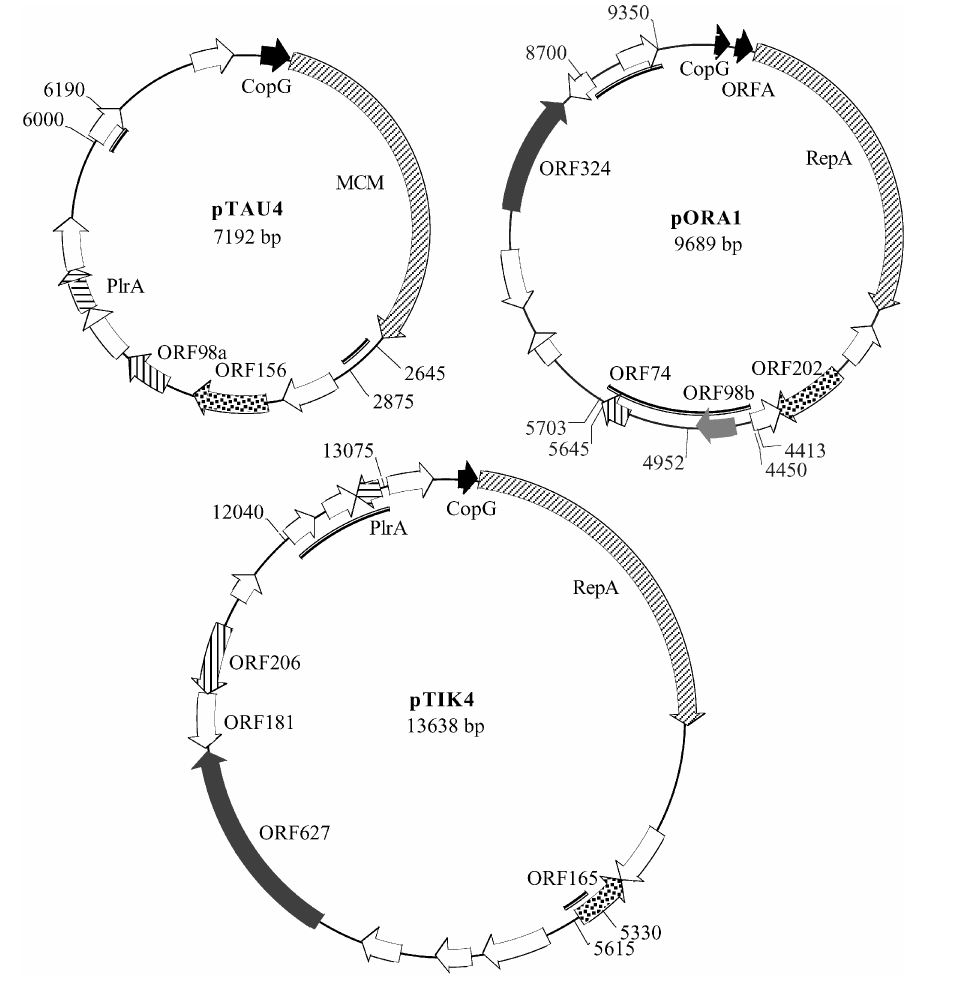
Figure 1. Circular gene maps of plasmids pTAU4, pORA1 and pTIK4. Open reading frames (ORFs) presented in ei- ther black, or identical pat- terns, are homologous. Gray- shaded ORFs yield matches in public sequence databases (see Table 1). Regions exhibiting a high concentration of direct or inverted repeats, or both, are drawn inside the circular ge- nome with a thick black line and the nucleotide positions bordering the regions are given. The positions of five identical 18-bp palindromic re- peats in pORA1 are indicated between positions 4413 and 5703. Position 1 of the ge- nome sequence immediately precedes the promoter region of the CopG gene in each